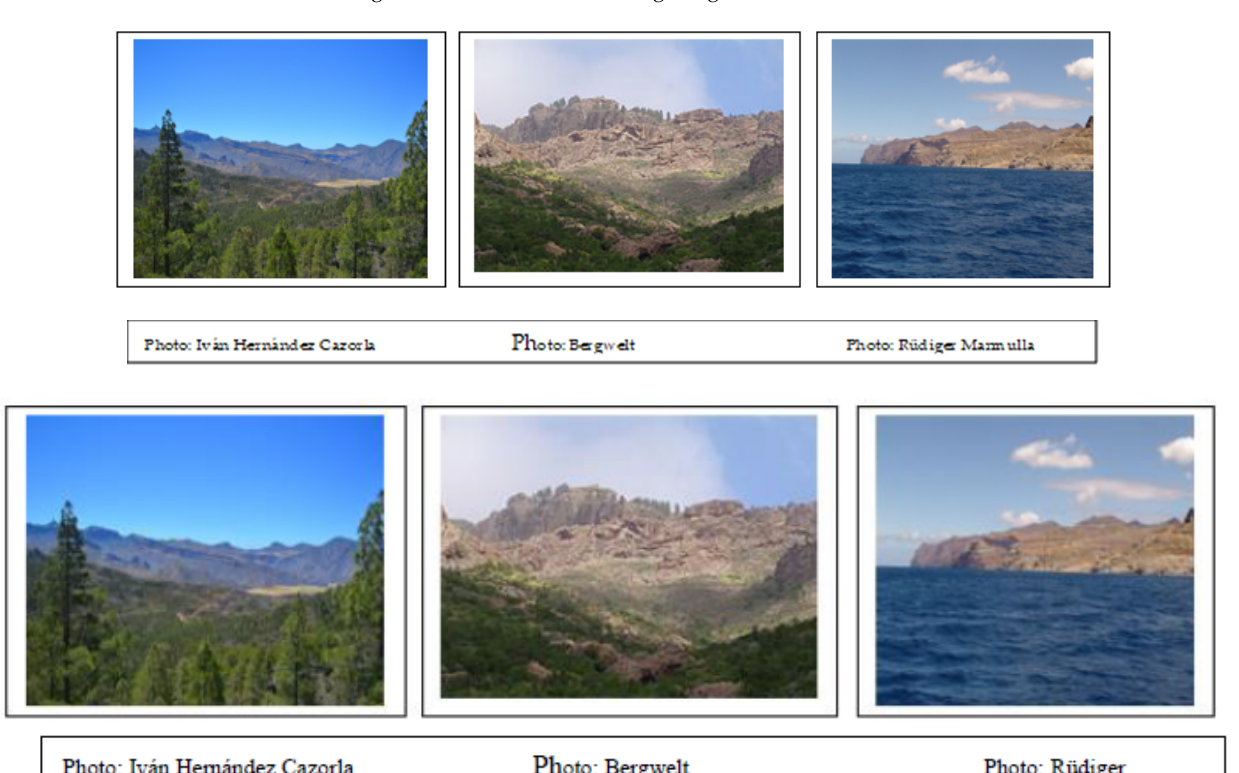
Figure A1. Diagram of the environmental, economic and social services of Tamadaba Natural Park that integrate the above values, configuring its total economic value.